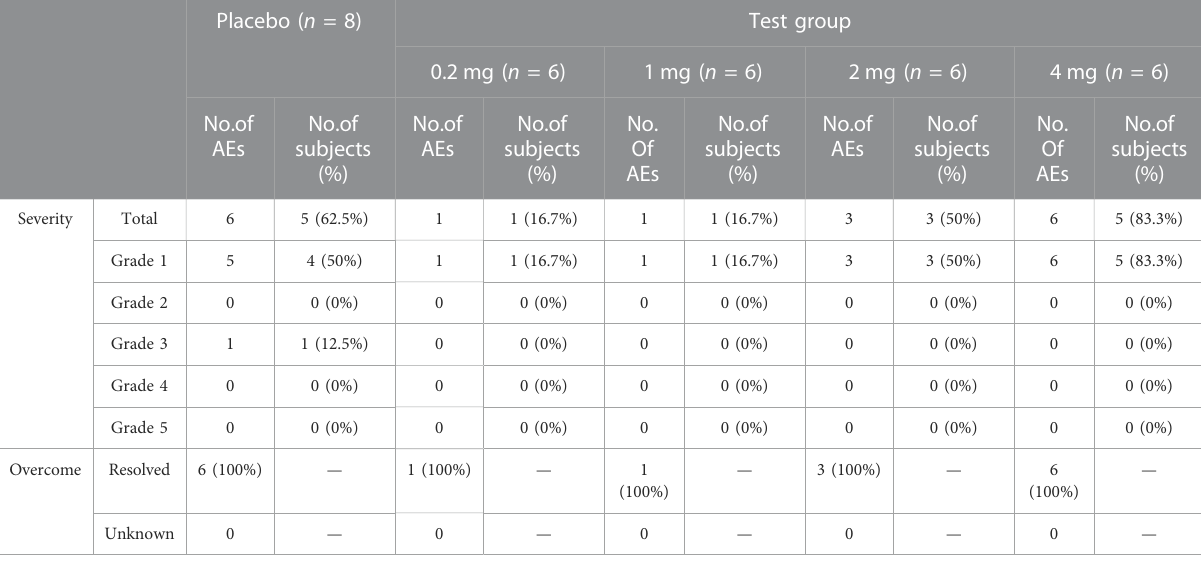
TABLE 2 Adverse events and their severity and outcome in patients in each dose